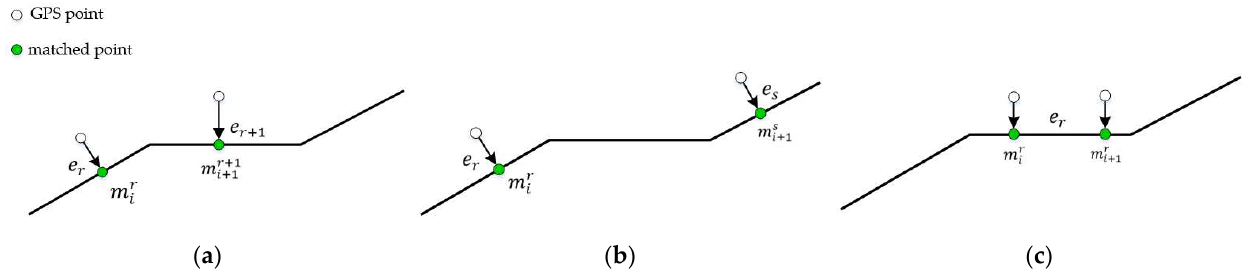
Figure 3. Three situations of the location relationship of adjacent two matched points: ( a ) m ir and r +1 are on adjacent road segments; ( b ) m ir and m m i +1 m r + 1 are on adjacent road segments; ( b ) m r r are on the same road segment. i + 1 m ir and m i +1 and m r are on the same road i + 1